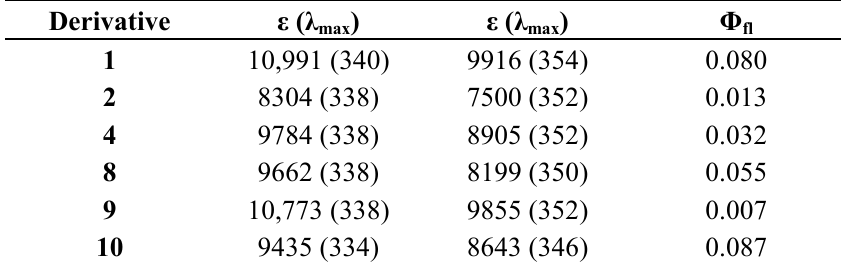
Table 3. Absorption and emission properties of investigated